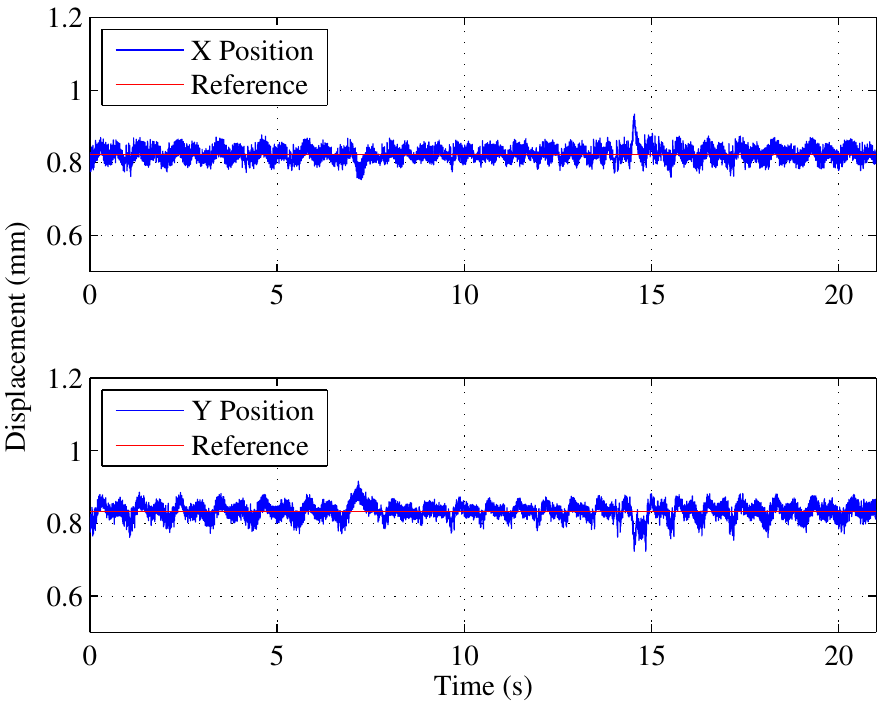
Figure 15. Three-phase system position response for load